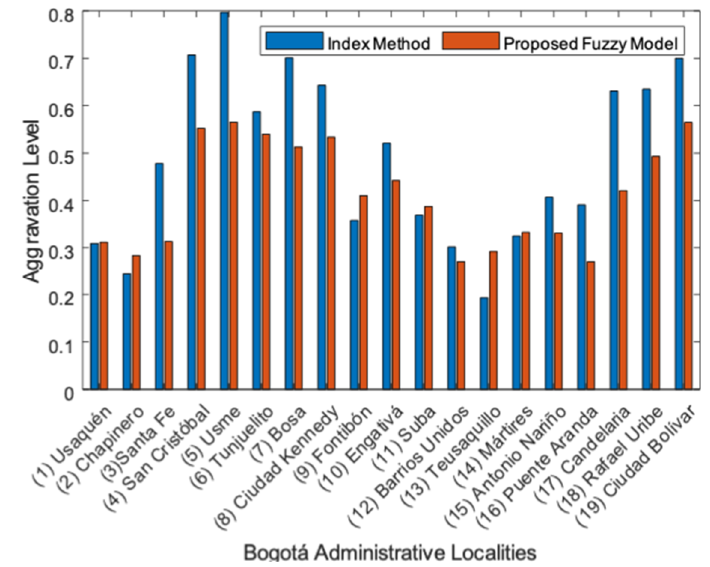
Figure 9. Aggravation values obtained for the 19 administrative localities of Bogotá with the index method and the proposed fuzzy